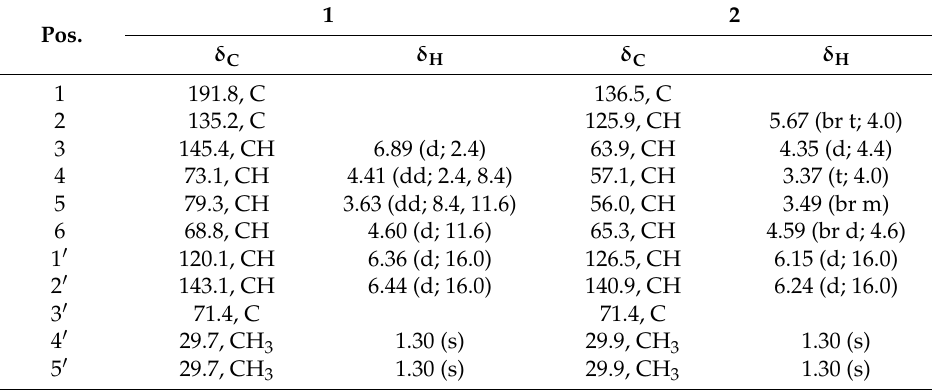
Table 1. NMR data for compounds 1 – 2 in MeOH -d 4 , ( J in Hz; 1 H-NMR at 400 MHz; 13 C-NMR at 100